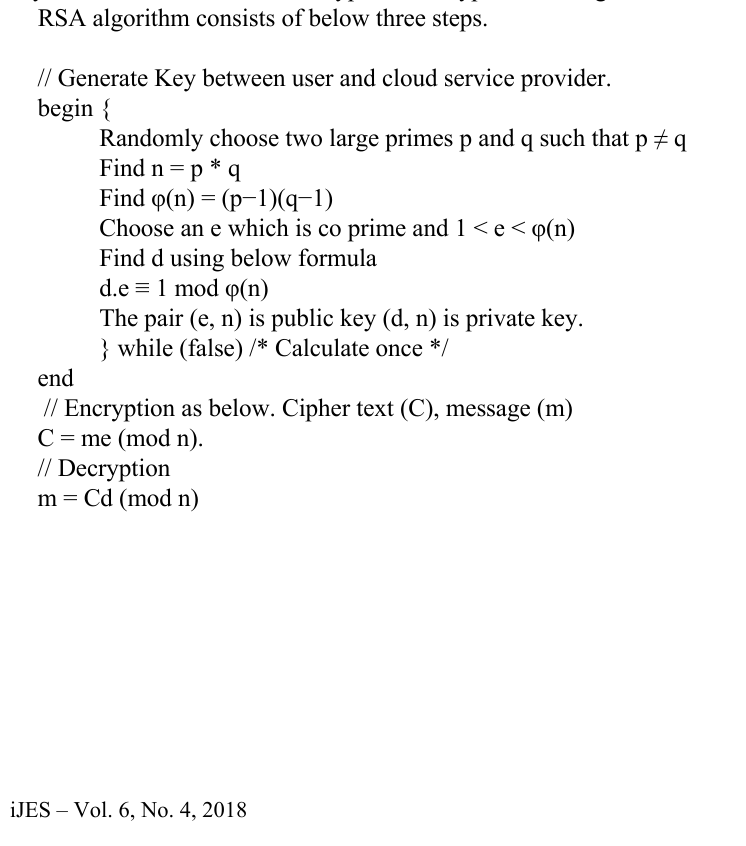
Short Paper —Securing Cloud Data using RSA